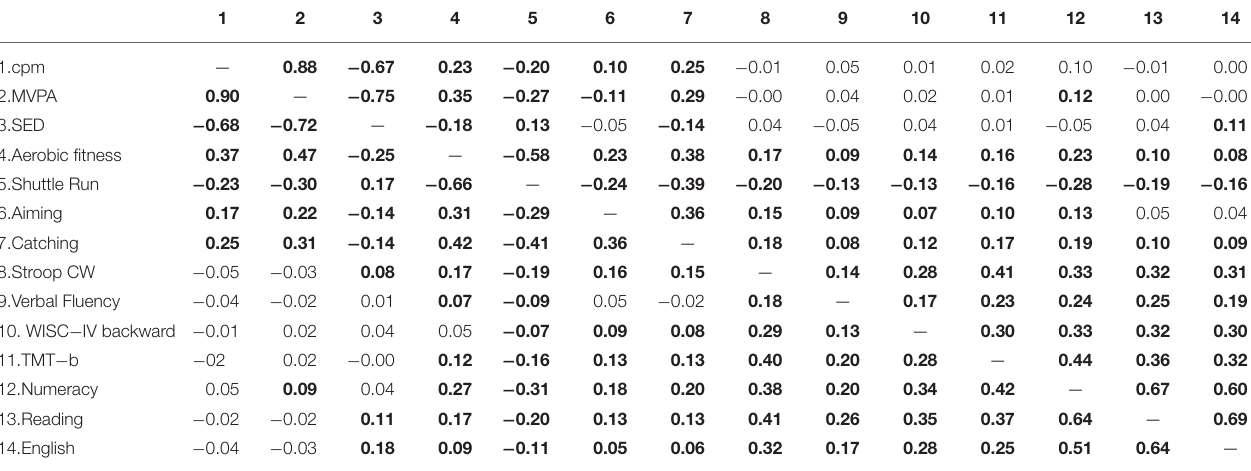
TABLE 2 | Estimated correlation matrix for the independent and dependent variables at baseline (above the diagonal line) and at follow-up (below the diagonal